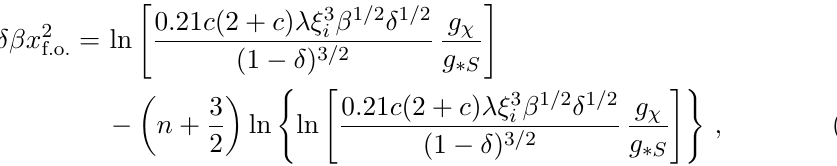
Figure 13 . The abundance evolution of χ 1 and χ 2 for m χ a function of x (left) and x 0 (right), same as figure 2, except that the approximation lines, e − δx 0 Y tot , are omitted here. The additional parameters are modified to δ = 0 . 01 , ξ i = 0 . 1 (top), δ = 0 . 01 , ξ i = 0 . 01 (middle), and δ = 0 . 1 , ξ i = 0 . 01